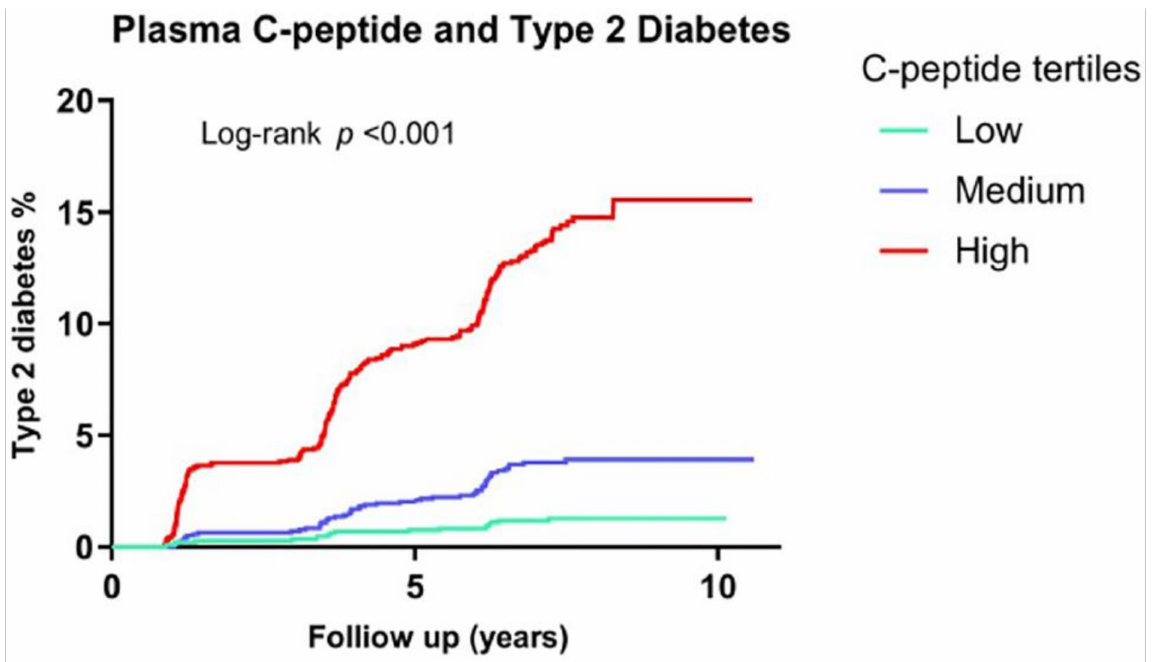
Figure 3. Kaplan–Meier curves for the development of diabetes according to sex-specific tertiles of C-peptide at baseline in 5176 participants of the PREVEND study. Low = M: <642, F: <592 pmol/L; medium = M: 642–890, F: 592–803 pmol/L; high = M: >890, F: >803 pmol/L; PREVEND: Prevention of Renal and Vascular End-Stage Disease. Note that in this population-based cohort, C-peptide levels in the highest tertile were associated with a higher incidence of type 2 diabetes during a median follow-up of 7, 2 years, compared to lower C-peptide levels ( p < 0.001), and this association was independent of age, sex, BMI, family history of diabetes, blood pressure, triglycerides, HDL cholesterol, and fasting plasma glucose. Reproduced from S. Sokooti, L.M. Kieneker, M.H. de Borst, A. Muller Kobold, J.E. Kootstra-Ros, J. Gloerich, A.J. van